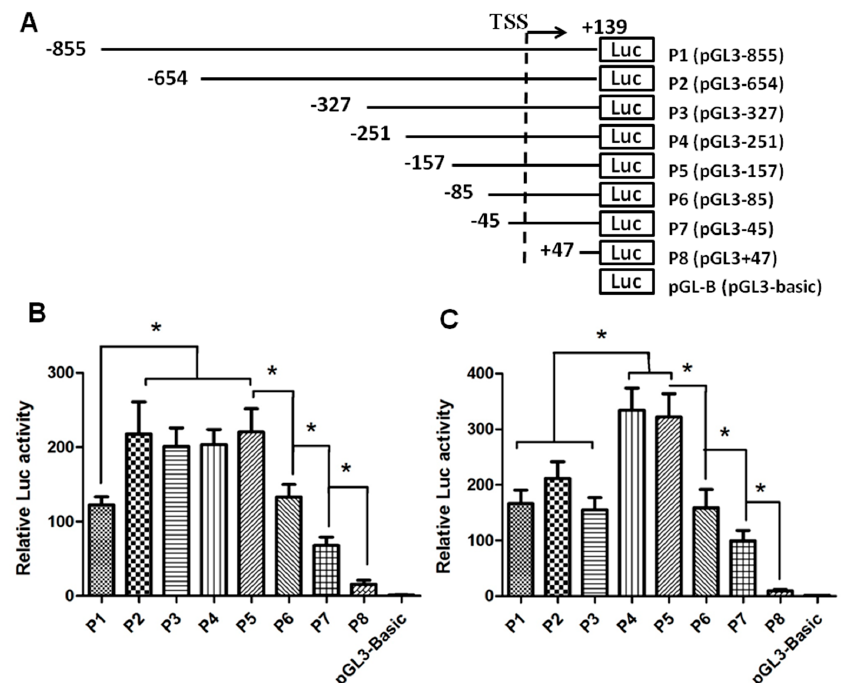
Figure 1. Activities of truncated SET (SE Translocation) transcript 2 promoters in HeLa and HEK 293 cells. ( A ) Schematic presentation of serial deletions in human SET transcript 2 promoter. Promoters